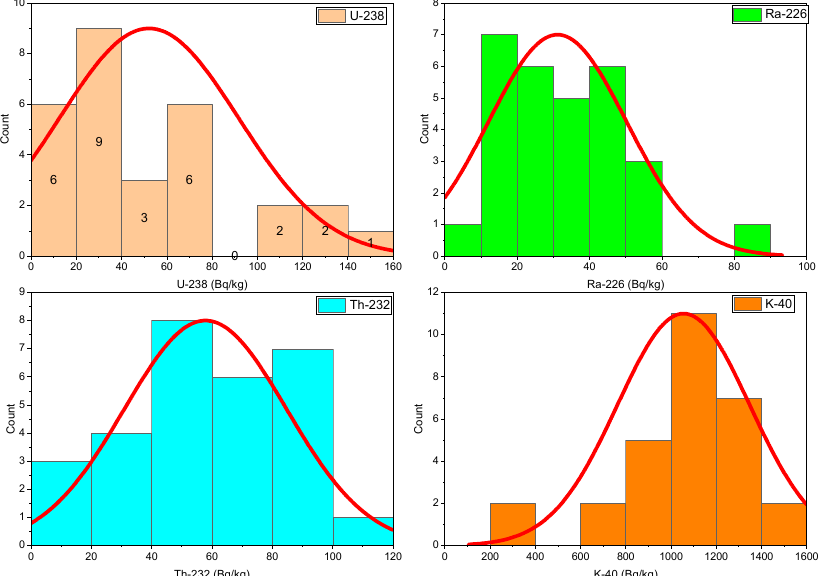
Figure 7. Frequency distribution of the 238 U, 226 Ra, 232 Th and 40 K radionuclides in granitic rocks samples.